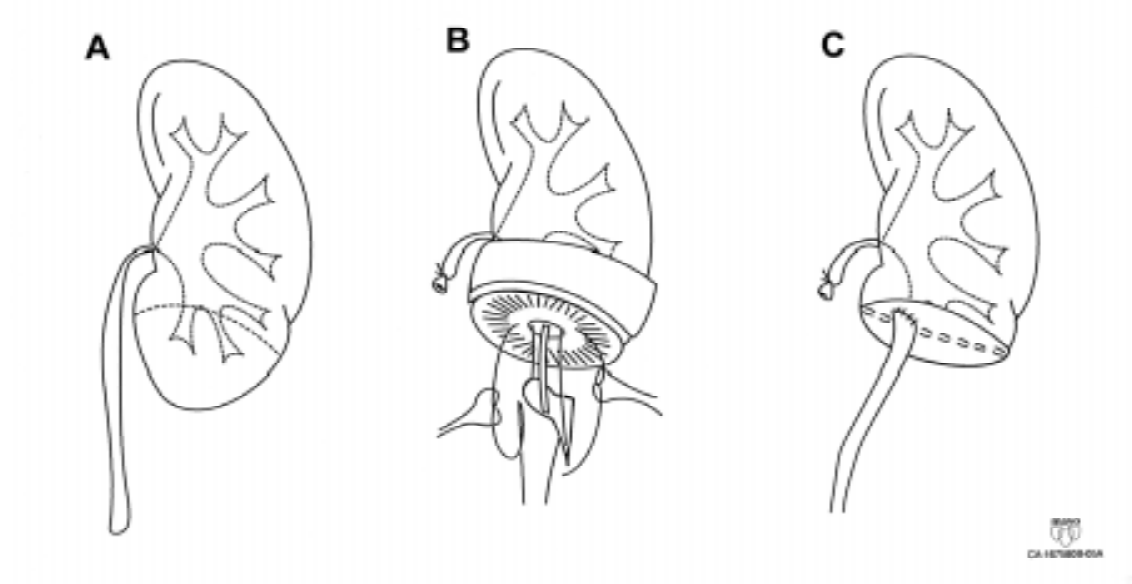
Figure 5 - Complex